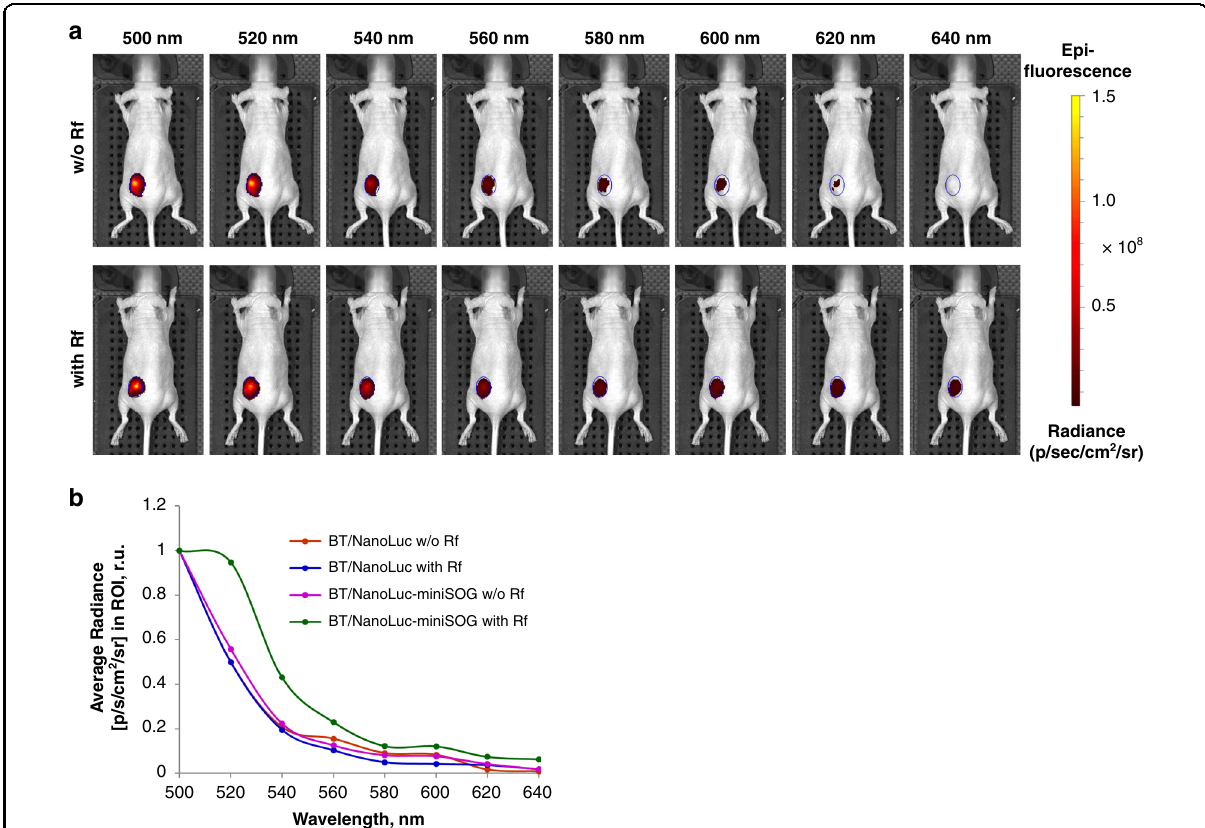
Fig. 3 Evidence of NanoLuc-mediated BRET effect in vivo. a Fluorescence images of NanoLuc-miniSOG-tumor-bearing animals. Photos are performed after i.v. furimazine administration without (top row) and with (bottom row) Rf pre-injection. The ROI are indicated as a blue-circled area. b Normalized fl uorescence intensity curves (in photons per second per cm 2 per steradian) from the tumor region measured with and without RF pre- injection for mice bearing NanoLuc (blue and red curves, respectively) or NanoLuc-miniSOG-expressing tumors (green and magenta curves,